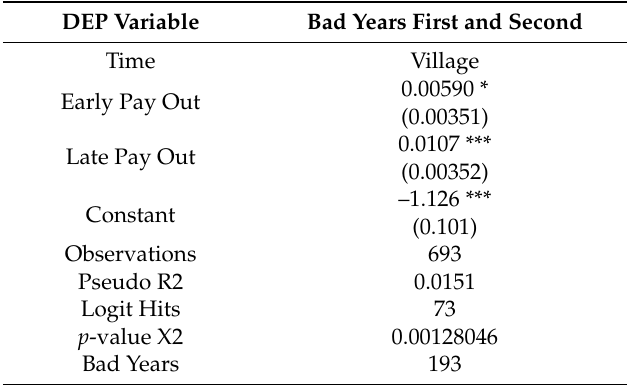
Table 5. Index-insurance payout